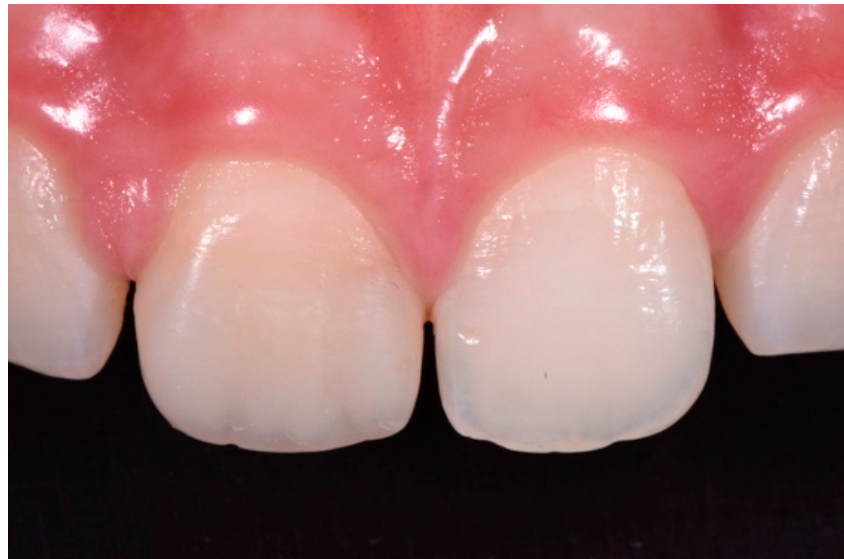
Figure 18. Five years post-operative.